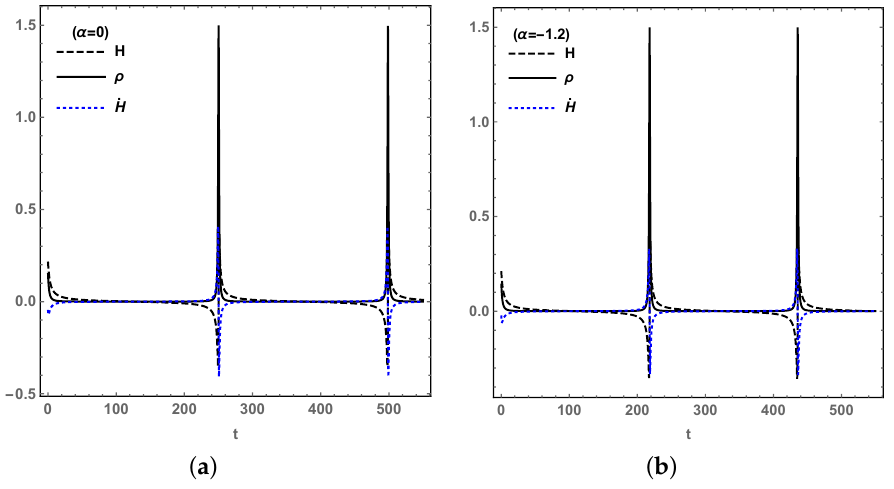
Figure 17. The bouncing happens in LQC, with parameters η = 2, n = − 4, A = 0.5, B = 0.3, with the initial values φ 0 = 1.85, ˙ φ 0 = 0.65, H 0 = 0.212 and ρ 0 = 0.15. ( a ) α = 0 for stable point P h 0 ; ( b ) α = − 1.2 for stable point P g